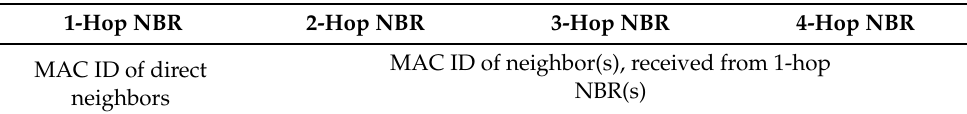
Table 1. Neighbor table of node N i .